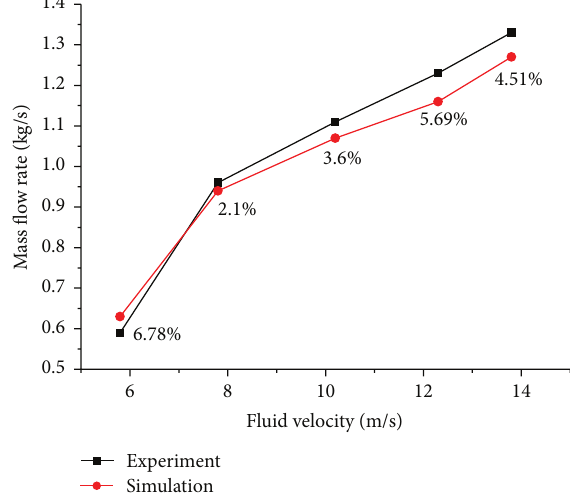
Figure 11: Relative error of the mass flow rate between simulation and experiment in